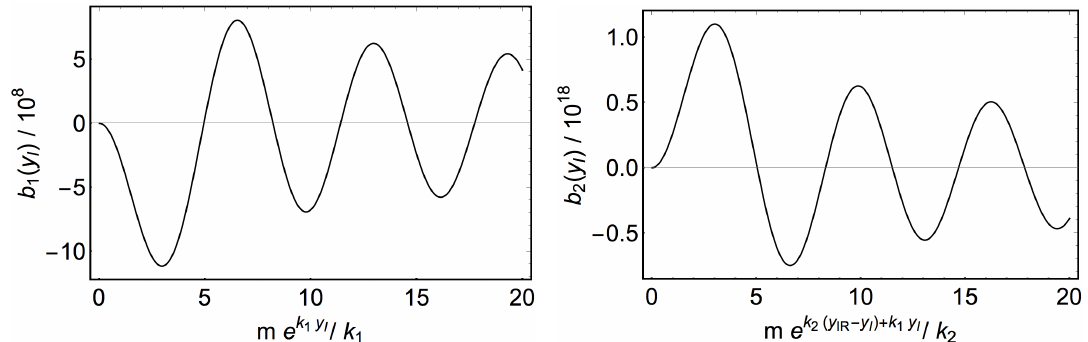
Figure 3 . The normalized b 1 ( y I ) in eq. (4.8) and b 2 ( y I ) in eq. (4.9) as functions of the nor- malized mass parameters, m e k 1 y I /k 1 and m e k 2 ( y IR − y I )+ k 1 y I /k 2 , respectively. Here, we take k 1 y I = 10 , k 2 y I = 20 , k 2 y IR = 40 , u 1 /k 1 = 0 . 15 , u 2 /k 2 = 0 . 075 as reference